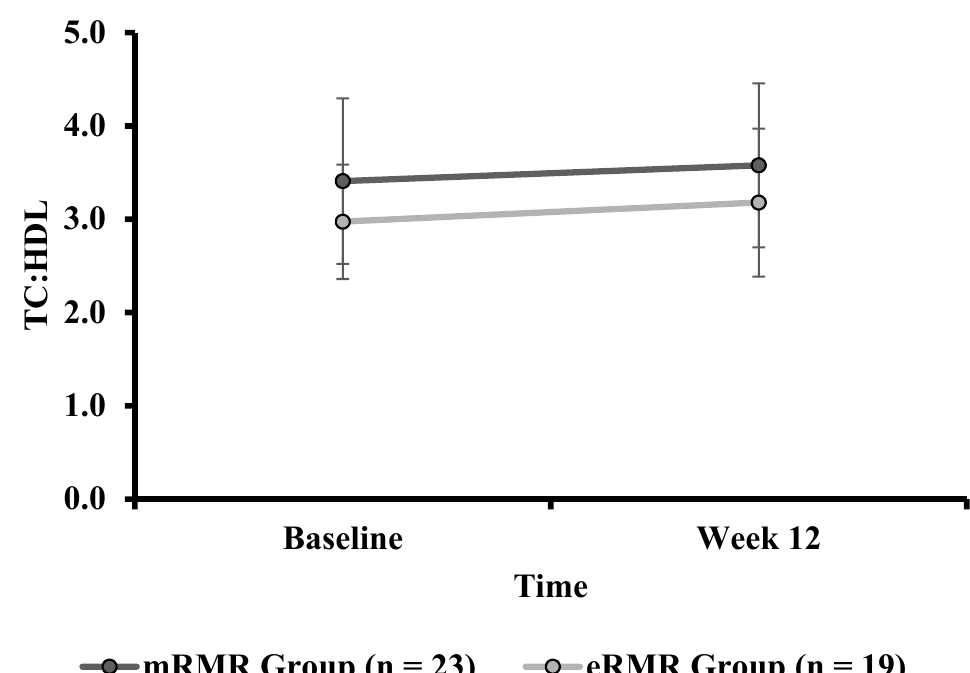
Figure 6. Total cholesterol to high-density lipoprotein ratio calculated at baseline and week 12 in both the mRMR ( n = 23) and estimated eRMR groups ( n = 19) groups. 3.16. Low-Density